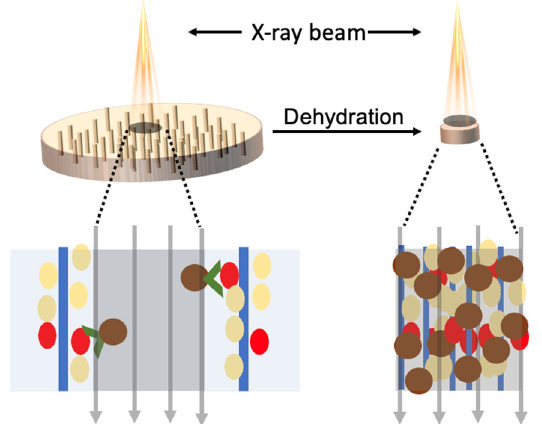
Figure 1. Enhanced X-ray fluorescence detection of biomarkers using nanoparticle probes with de- hydrated microchannel